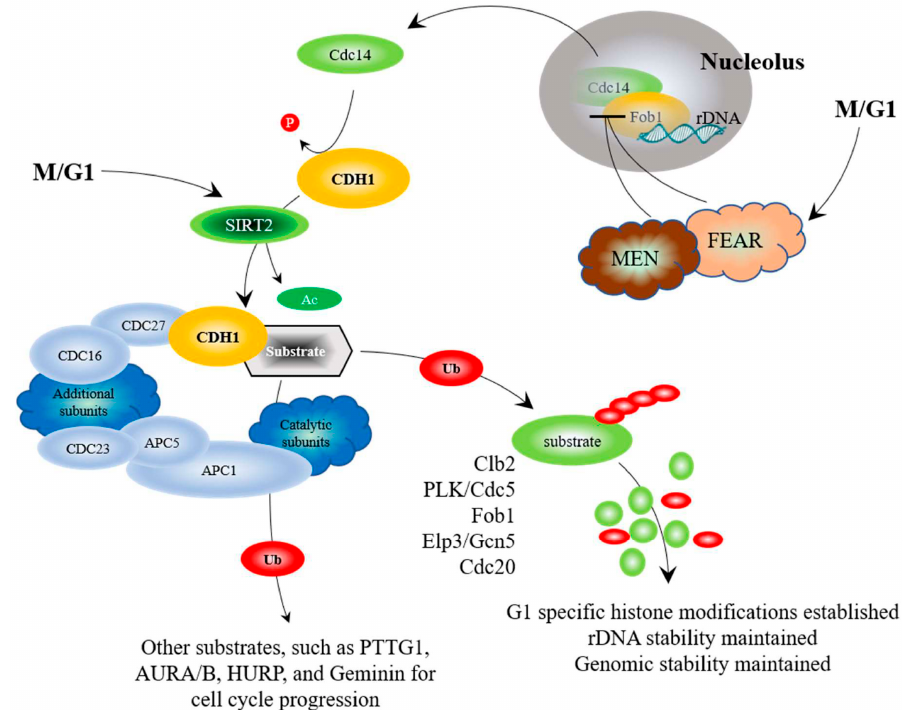
stops inhibition of Cdh1, allowing replacement of the APC Cdc20 complex with APC Cdh1 . APC chemical inhibitors, APCIN and pro-TAME, disrupt the CDC20-APC interaction [86,87], whereas the small [86,87], whereas the small molecule APC activators (M2I-1, TTKi) disrupt the CDC20-SAC interaction molecule APC activators (M2I-1, TTKi) disrupt the CDC20-SAC interaction [88–90]. Protein degradation [88–90]. Protein degradation is shown by Ub, shaded with a red oval, attached to the target protein to is shown by Ub, shaded with a red oval, attached to the target protein to build poly-Ub chains, followed build poly-Ub chains, followed by break down of the protein, shown in smaller circles. Inhibitory by break down of the protein, shown in smaller circles. Inhibitory phosphorylation is shown with a red phosphorylation is shown with a red shaded “P”, and activating phosphorylation is shown with a shaded “P”, and activating phosphorylation is shown with a green shaded “P”. green shaded “P”.